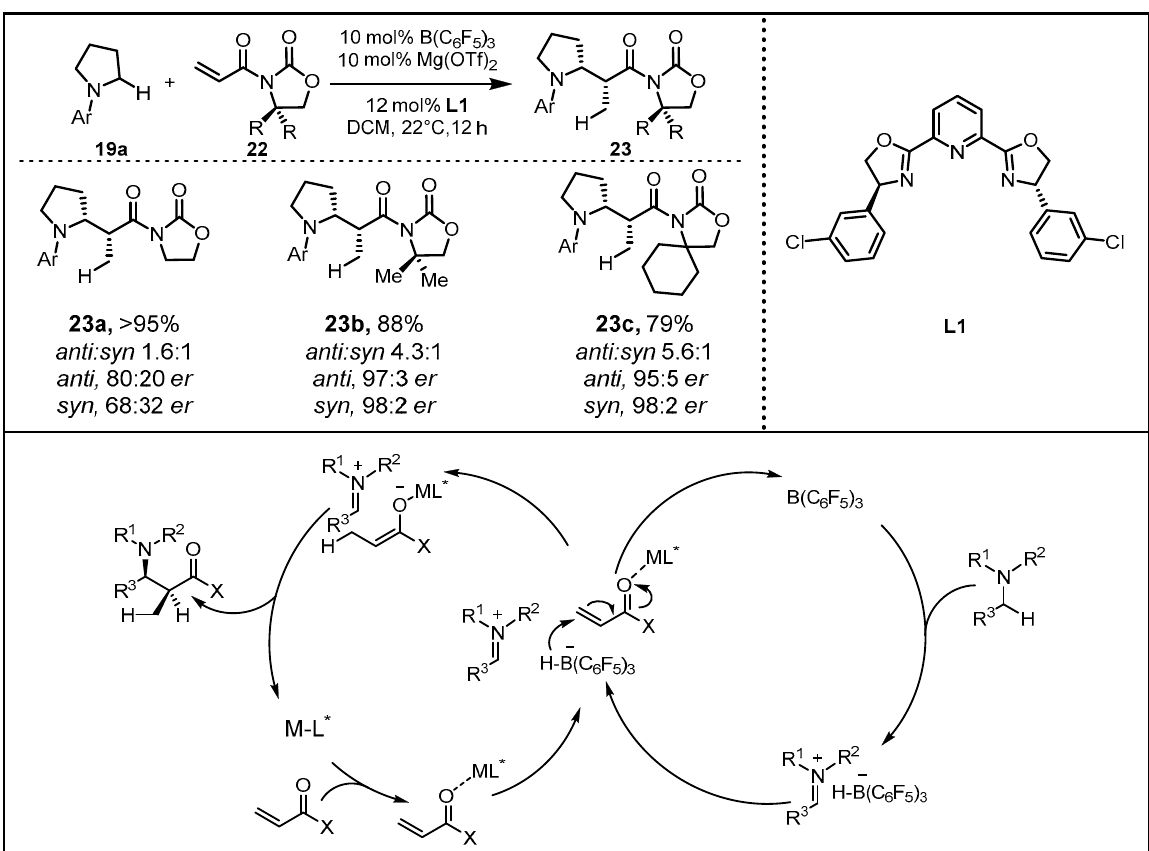
Figure 9. B(C 6 F 5 ) 3 and Mg(OTf) 2 / L1 -induced synthesis of β -amino amides.